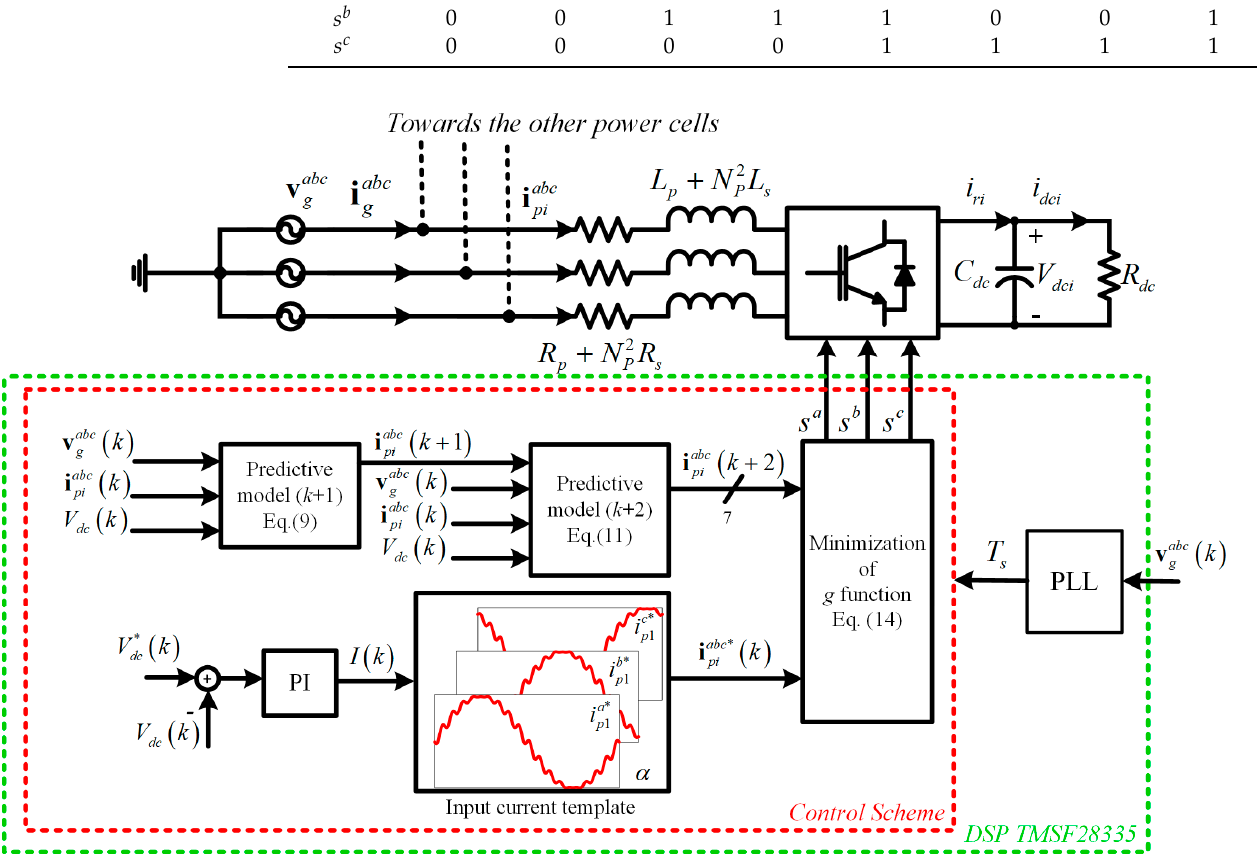
Figure 4. Control scheme in each power cell.